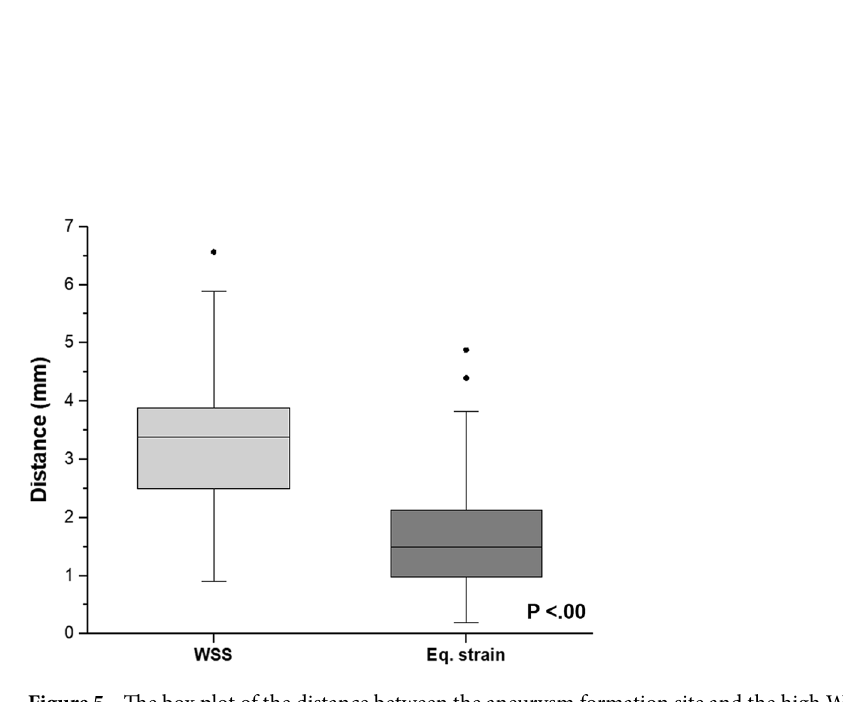
Figure 5. The box plot of the distance between the aneurysm formation site and the high WSS or high strain. The lower and upper borders represent the 25th and 75th percentiles, respectively, while the central bar indicates the median and the dots are outliers defined by values that are greater than the 90th or less than the 10th